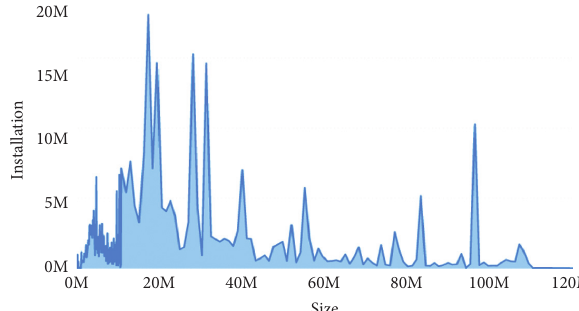
Figure 6: Relationship between app size and the number of installs.